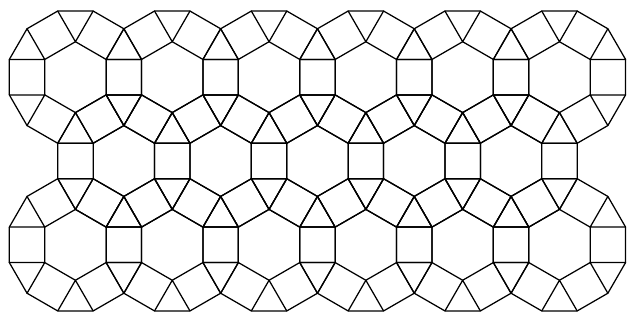
Fig. 2: Topological structure of a tiling with unique vertex corona consisting of a triangle, two quadrilat- erals and a hexagon.